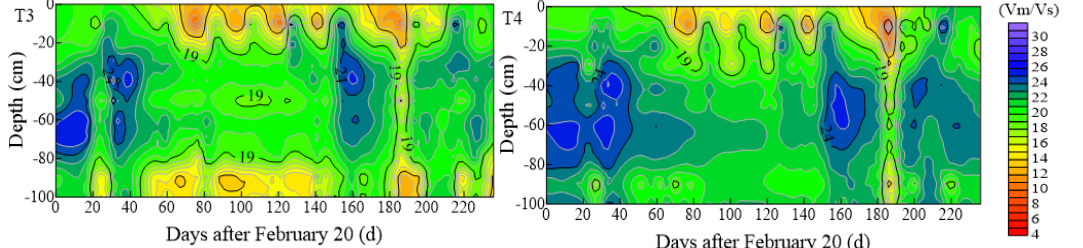
Figure 3. Spatiotemporal distribution of soil moisture between rows and between trees within the row in 2016.